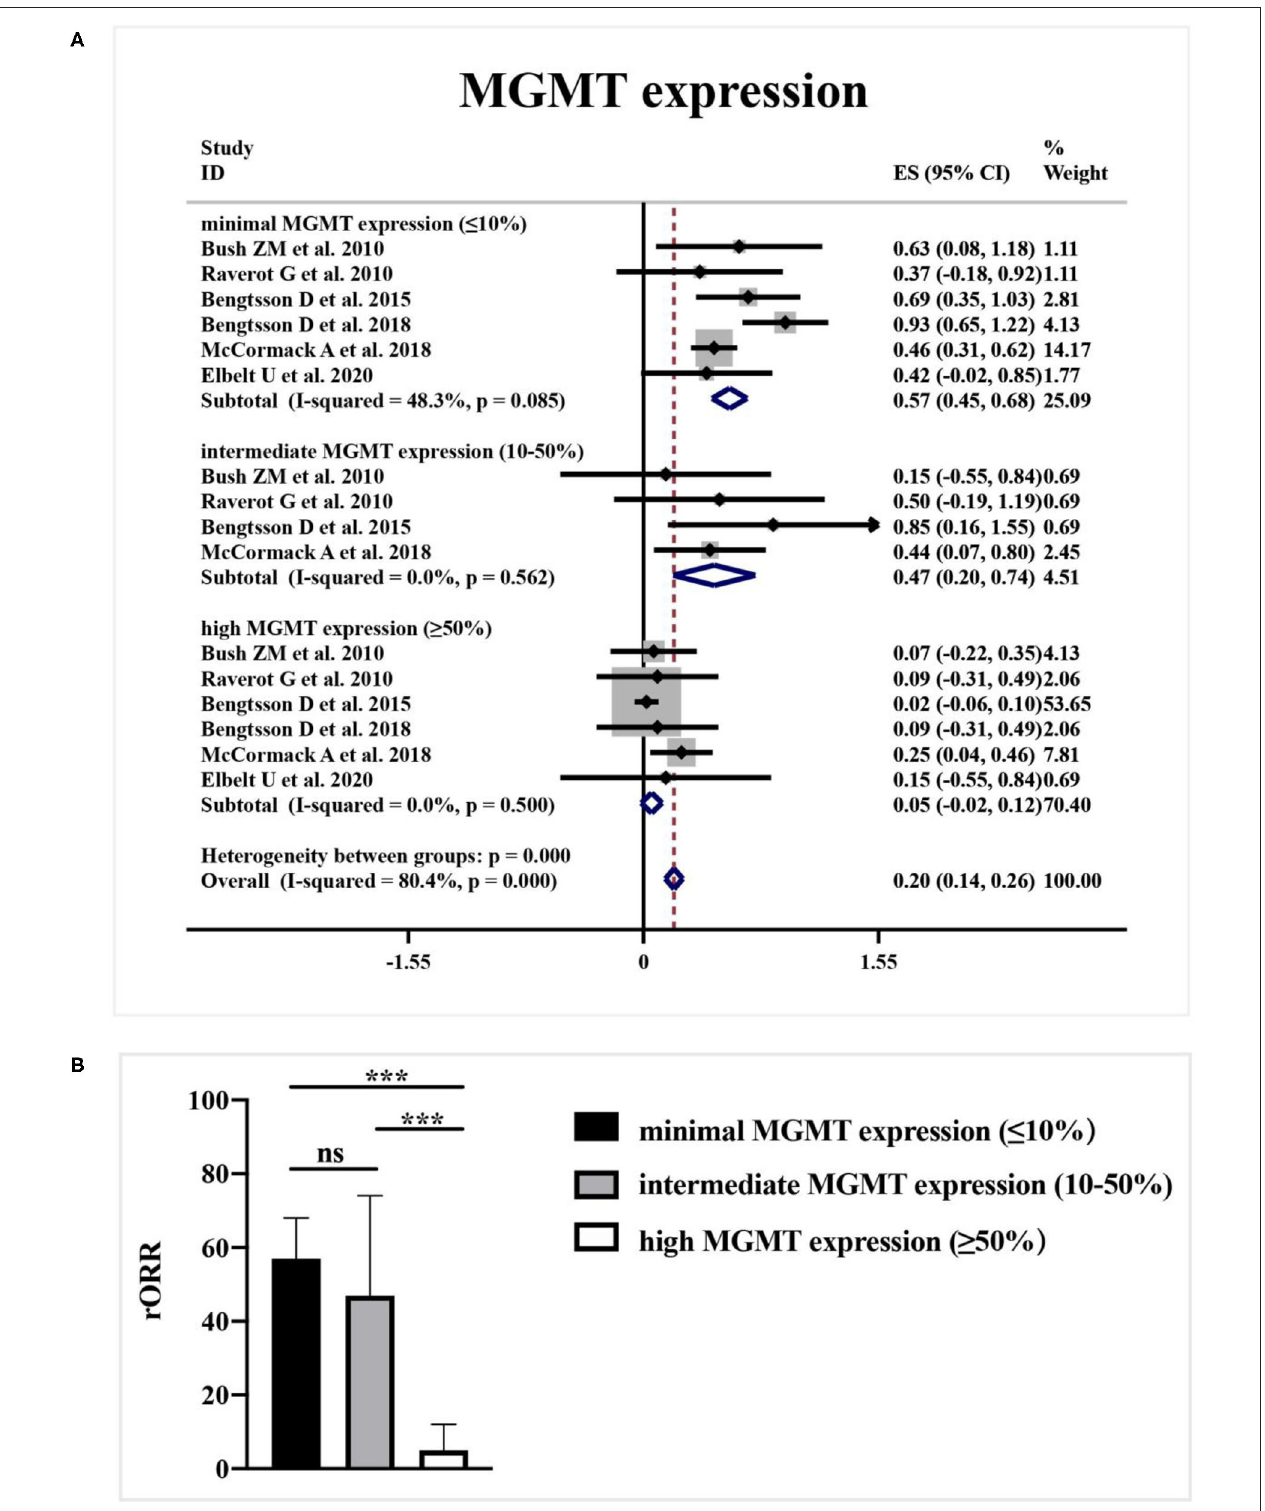
FIGURE 4 | The correlation between MGMT expression level and TMZ radiological response. (A) Radiological response rate was 57% in patients with minimal-MGMT expression, 47% in patients with intermediate-MGMT expression, and 5% in patients with high-MGMT expression. (B) Radiological response rate was spectacularly lower in APT and PC patients with high-MGMT expression than those with minimal and intermediate-MGMT expression group in the quantitative histogram. *** P < 0.001.